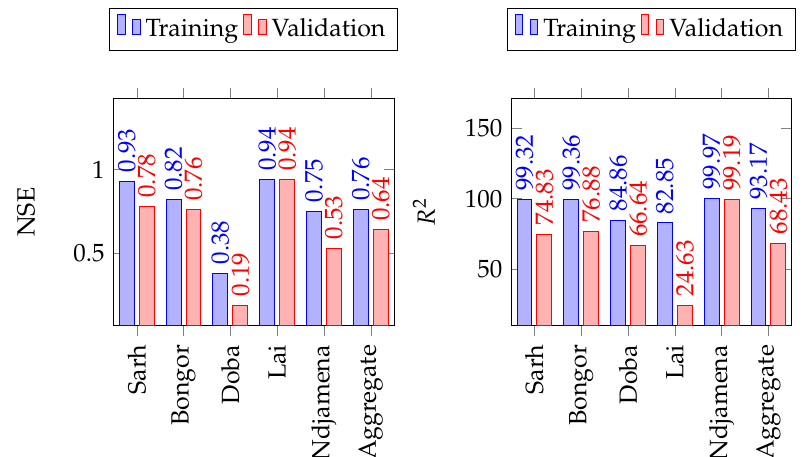
Figure 6. Comparison of SDSM performance on the training and validation sets for monthly minimum temperature forecast in the Lake Chad Basin.